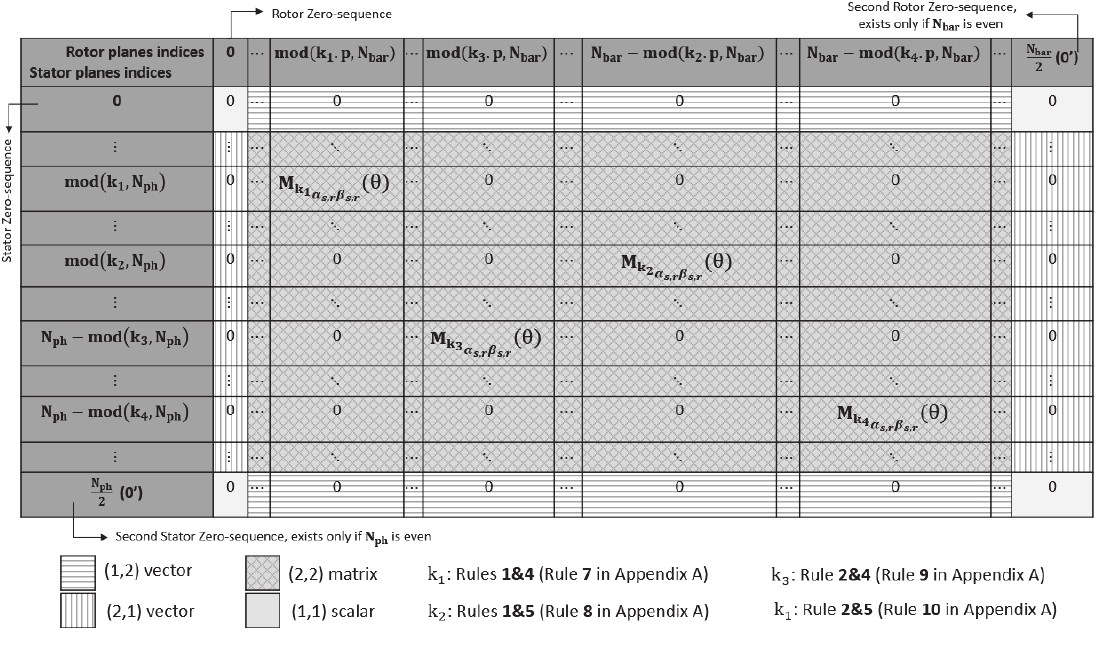
( θ ) (cid:4666)θ(cid:4667) . Figure 2. Transformed Stator–Rotor mutual inductance matrix L sr αβ (cid:3209)(cid:3210)